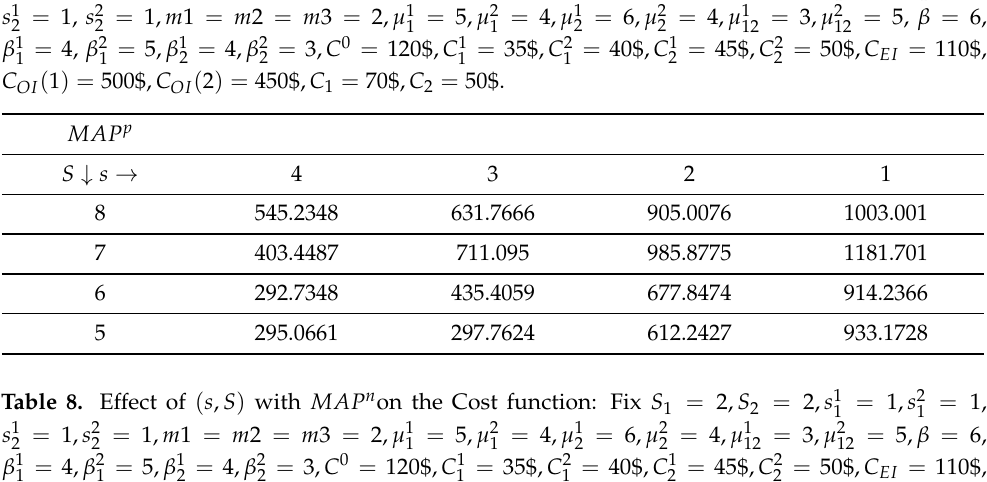
Table 7. Effect of ( s , S ) with MAP p on the Cost function: Fix S 1 = 2, S 2 = 2, s 1